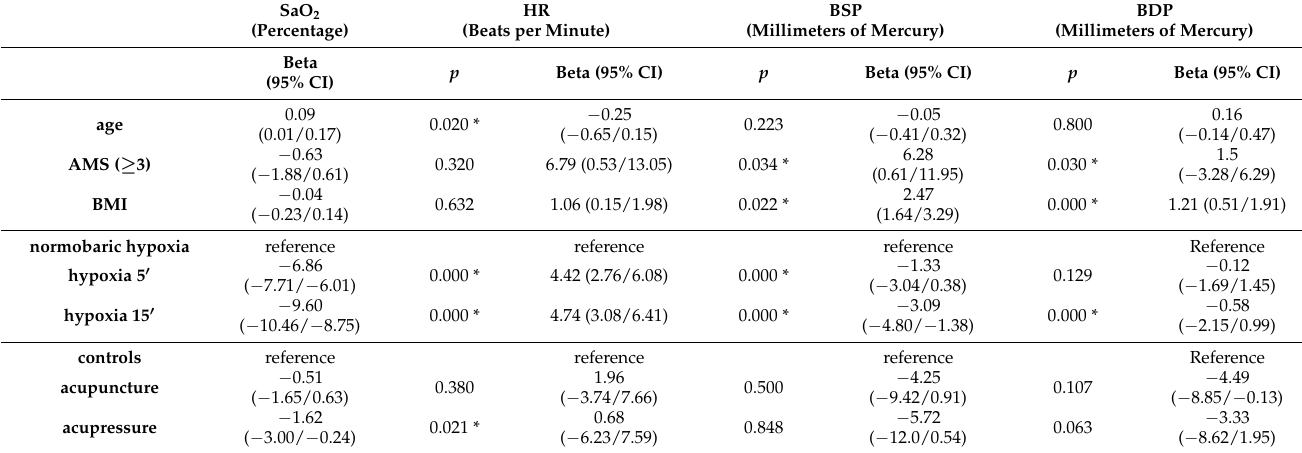
Table 3. Evaluation of oxyhaemoglobin saturation (SaO 2 ), heart rate (HR), systolic and diastolic blood pressure (SBP and DBP) in normoxia, in acute normobaric hypoxia for 15 min, in basal conditions, and after PC6 stimulation. Multilevel mixed- effects linear regression adjusted for age, acute mountain sickness (AMS), and body mass index (BMI) multivariate